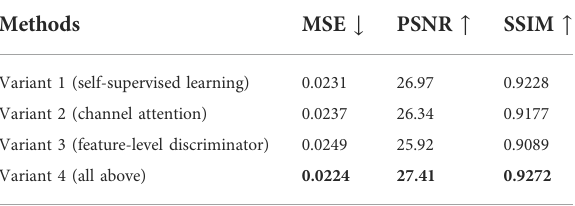
TABLE 5 Comparison results of the objective evaluation on different variants of our method (T1+T2 → Flair). Methods